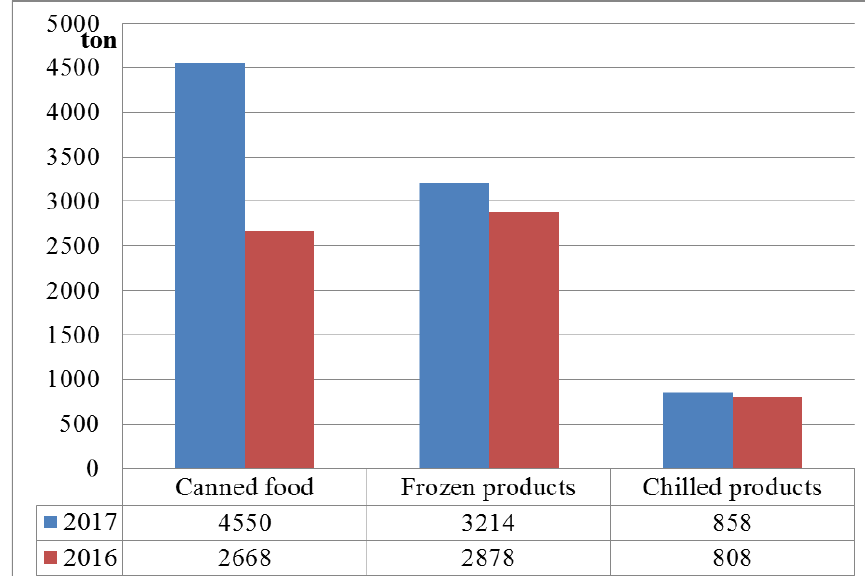
Fig. 3. The export of fish and fish products of Ukraine in 2016–2017 (according to the State Statistics Committee of Ukraine) In 2017 most of all Ukraine exported the fish products to such countries as: Moldova (1424 tons), Germany (1036